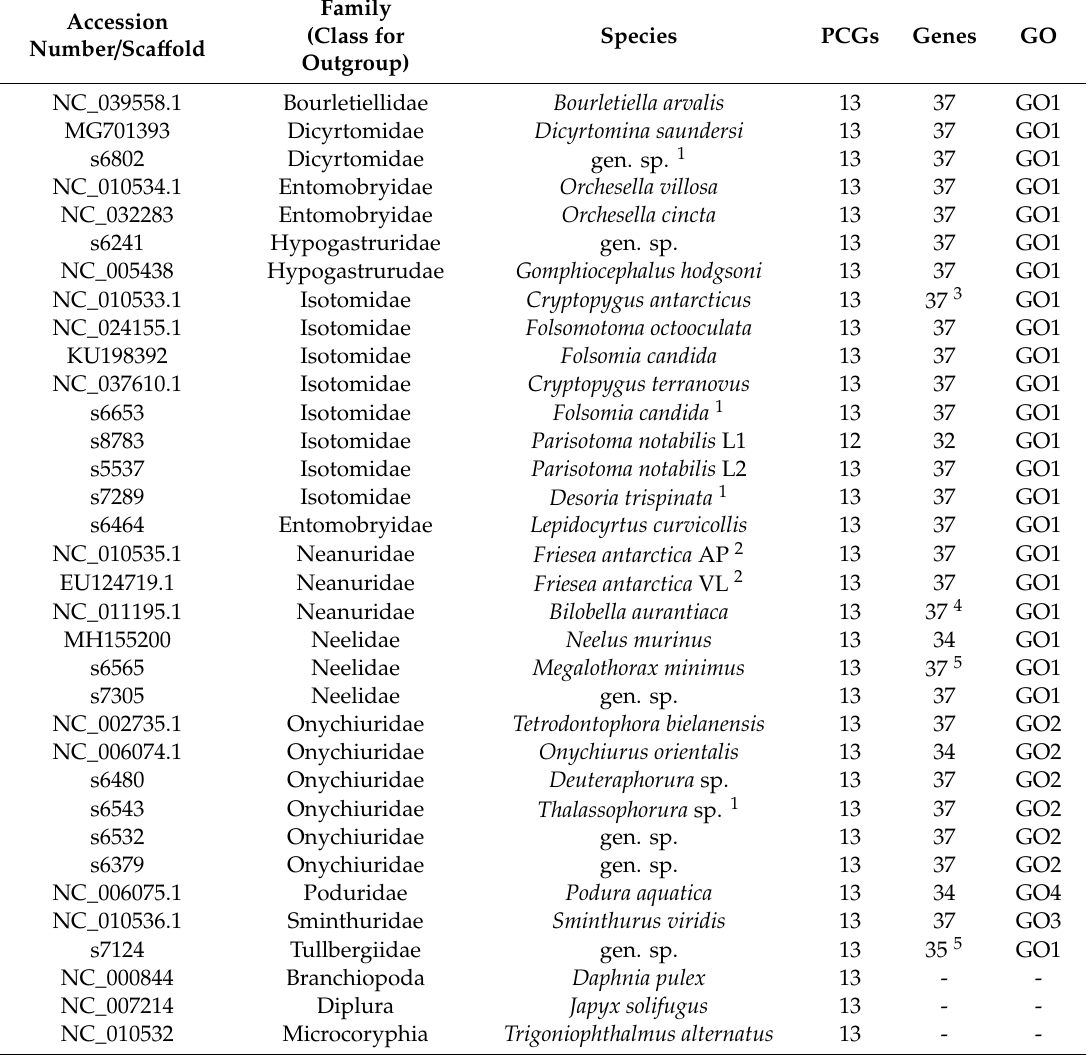
Table 1. Data set used for the phylogenetic and dating analyses. See Table S1 for complete